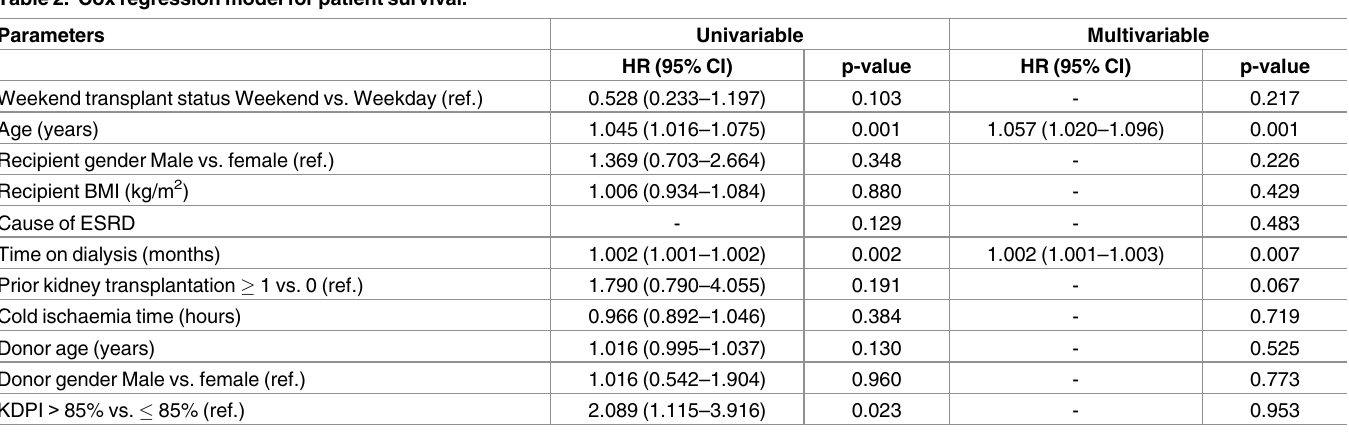
Table 2. Cox regression model for patient